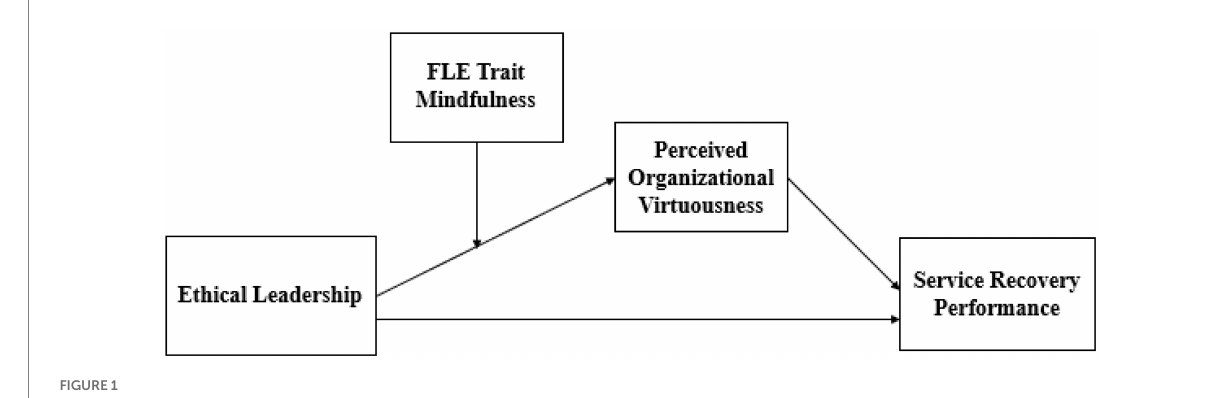
FIGURE 1 The proposed